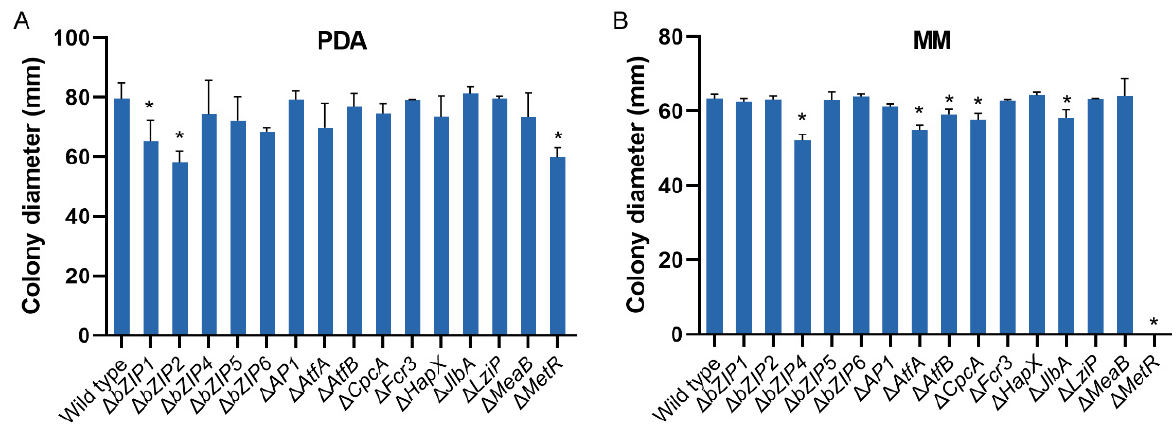
Figure 4. Mycelial growth of Aspergillus flavus strains on media. In total, 1 × 10 4 spores were cultured on PDA ( A ) and MM ( B ) media for 7 days at 30 ◦ C. The diameter of colonies was measured. Error bars represent the SD. * p < 0.05, significant difference from the wild-type group as estimated by a Dunnett test. MM, minimal media; PDA, potato dextrose agar; SD, standard deviation. The conidiation of HMN mutants of the 15 bZIP transcription factors was also studied. The ∆ bZIP2 and ∆ MeaB mutants produced approximately 73.8% and 76.4% fewer conidia on PDA plates, respectively, compared with the wild-type fungus. In addition, the two